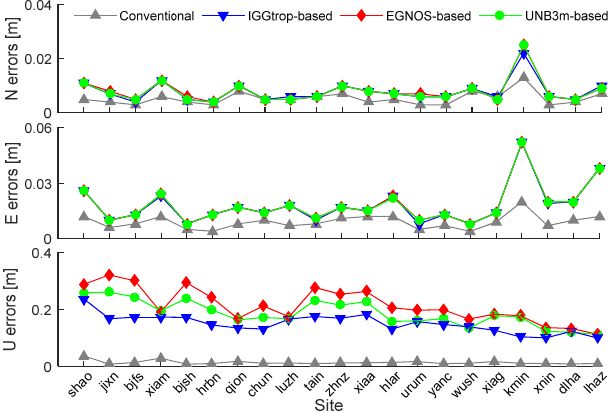
Figure 7. Mean positioning errors of the conventional PPP, IGGtrop-based, EGNOS-based and UNB3m-based PPP solutions over the period from January to December 2012 at selected stations. The upper, medium and bottom panels show the positioning errors in north, east and up directions, respectively.